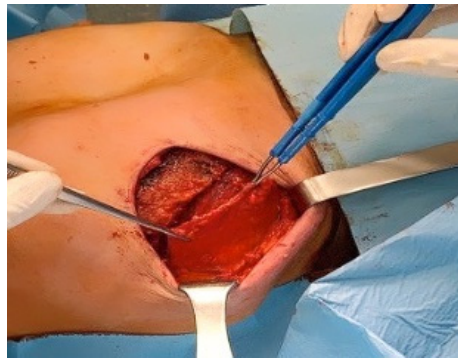
Figure 1. Serratus Fascia flap.